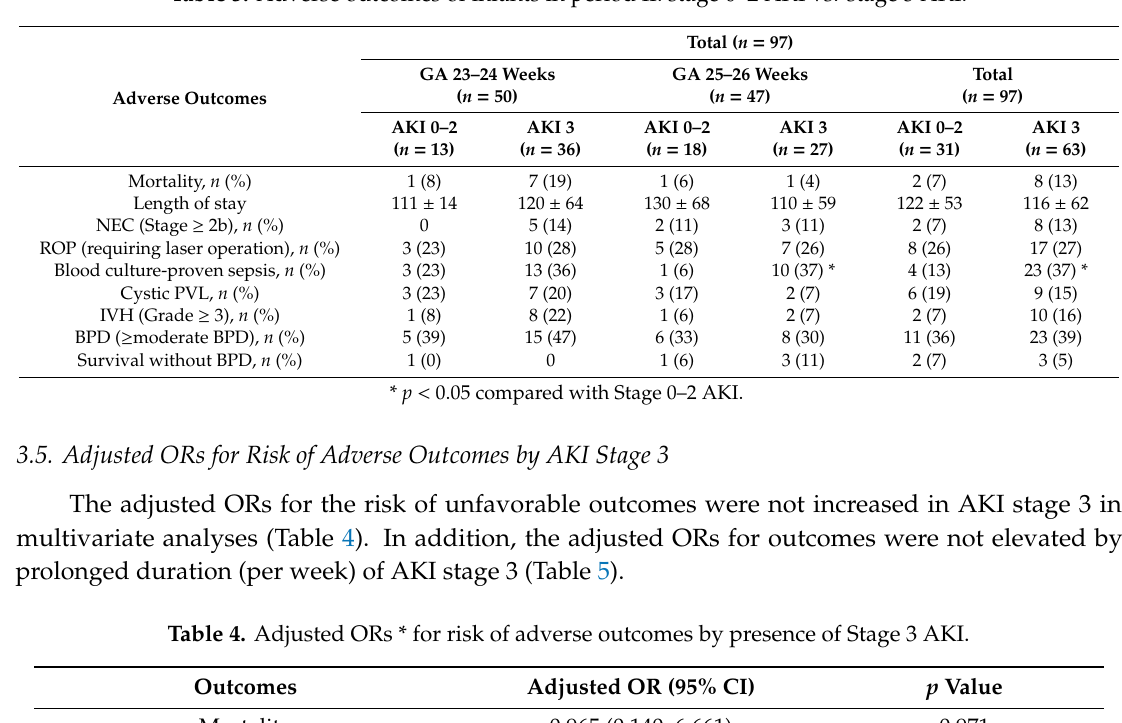
Table 3. Adverse outcomes of infants in period II: stage 0–2 AKI vs. stage 3 AKI.